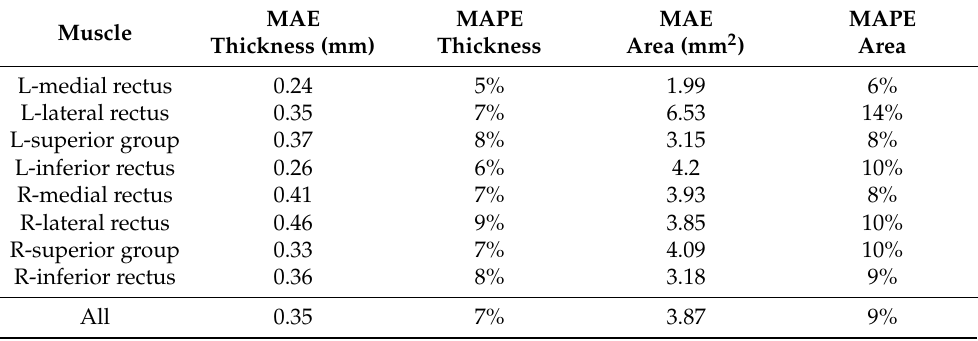
Table 5. Performance of selected U-net model (trained using WCE+Dice loss) on test data. Values indicate mean ± standard deviation of Dice score and IOU score on cross-validation